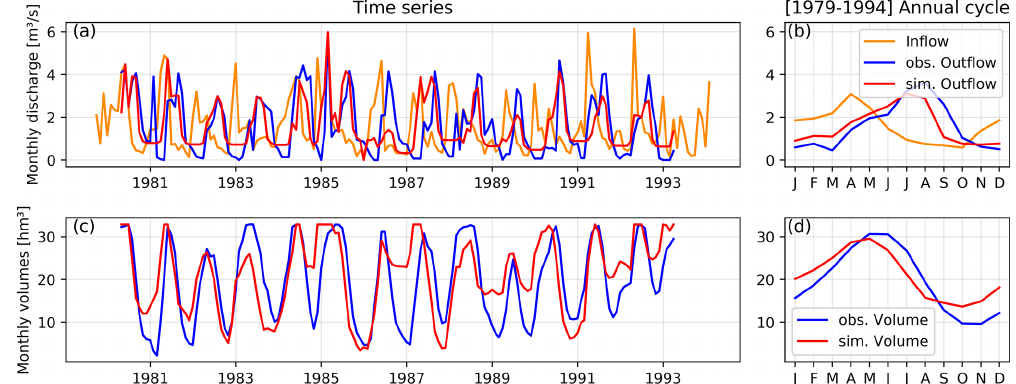
Figure 4. Simulation results for the Gonzalez Lacasa irrigation reservoir within the Ebro River basin over the period [1979–1994]. The monthly time series of dam releases and storage volumes are shown in panels (a) and (c) , respectively (observations are indicated in blue and simulations in red). Their corresponding mean annual cycles are shown in panels (b) and (d) ,